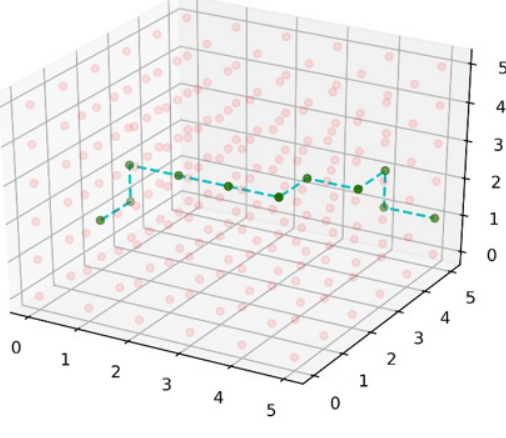
Figure 13. 3D-Dijkstra path.